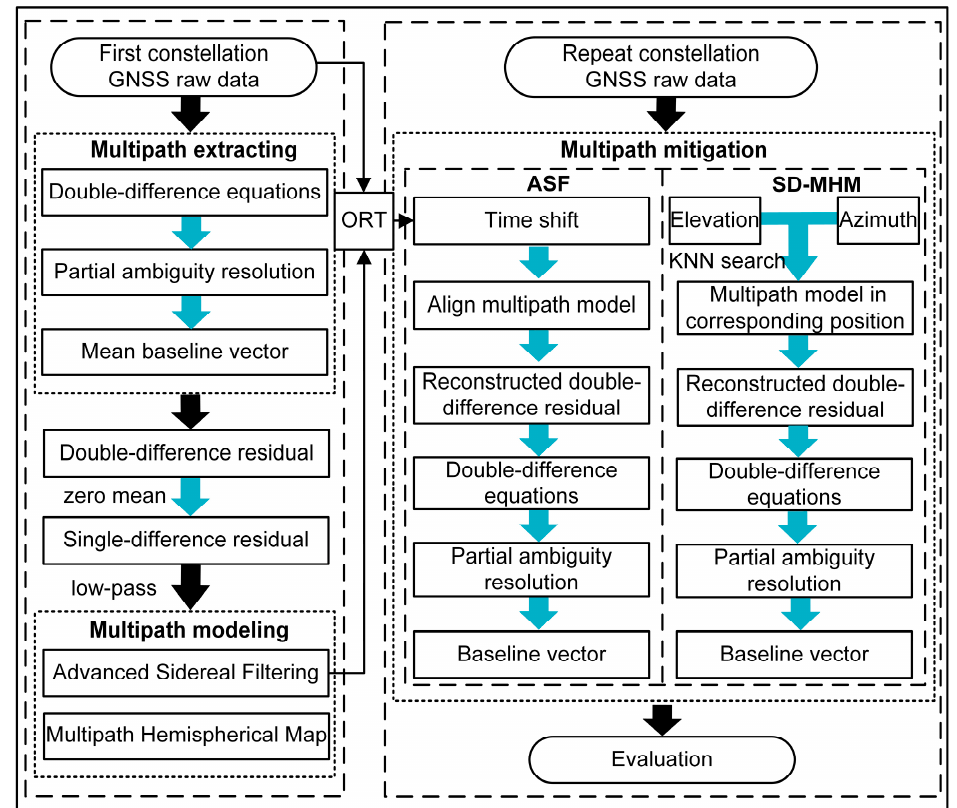
Figure 1. The framework of the ASF and SD-MHM construction and multipath mitigation.